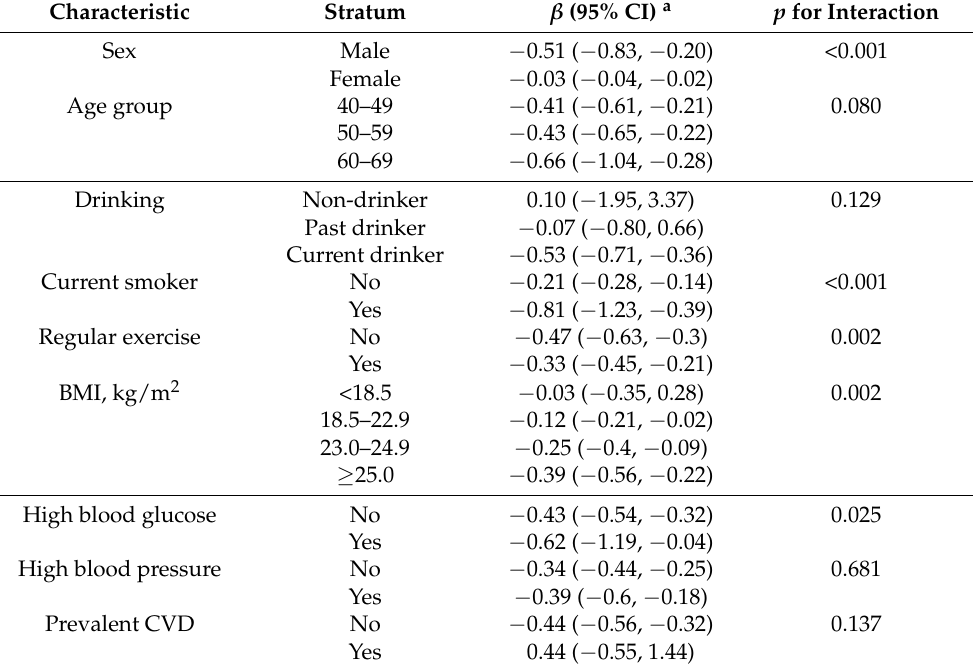
Table 4. Regression estimates and 95% CIs of eGFR per IQR increment in UPF intake according to participant